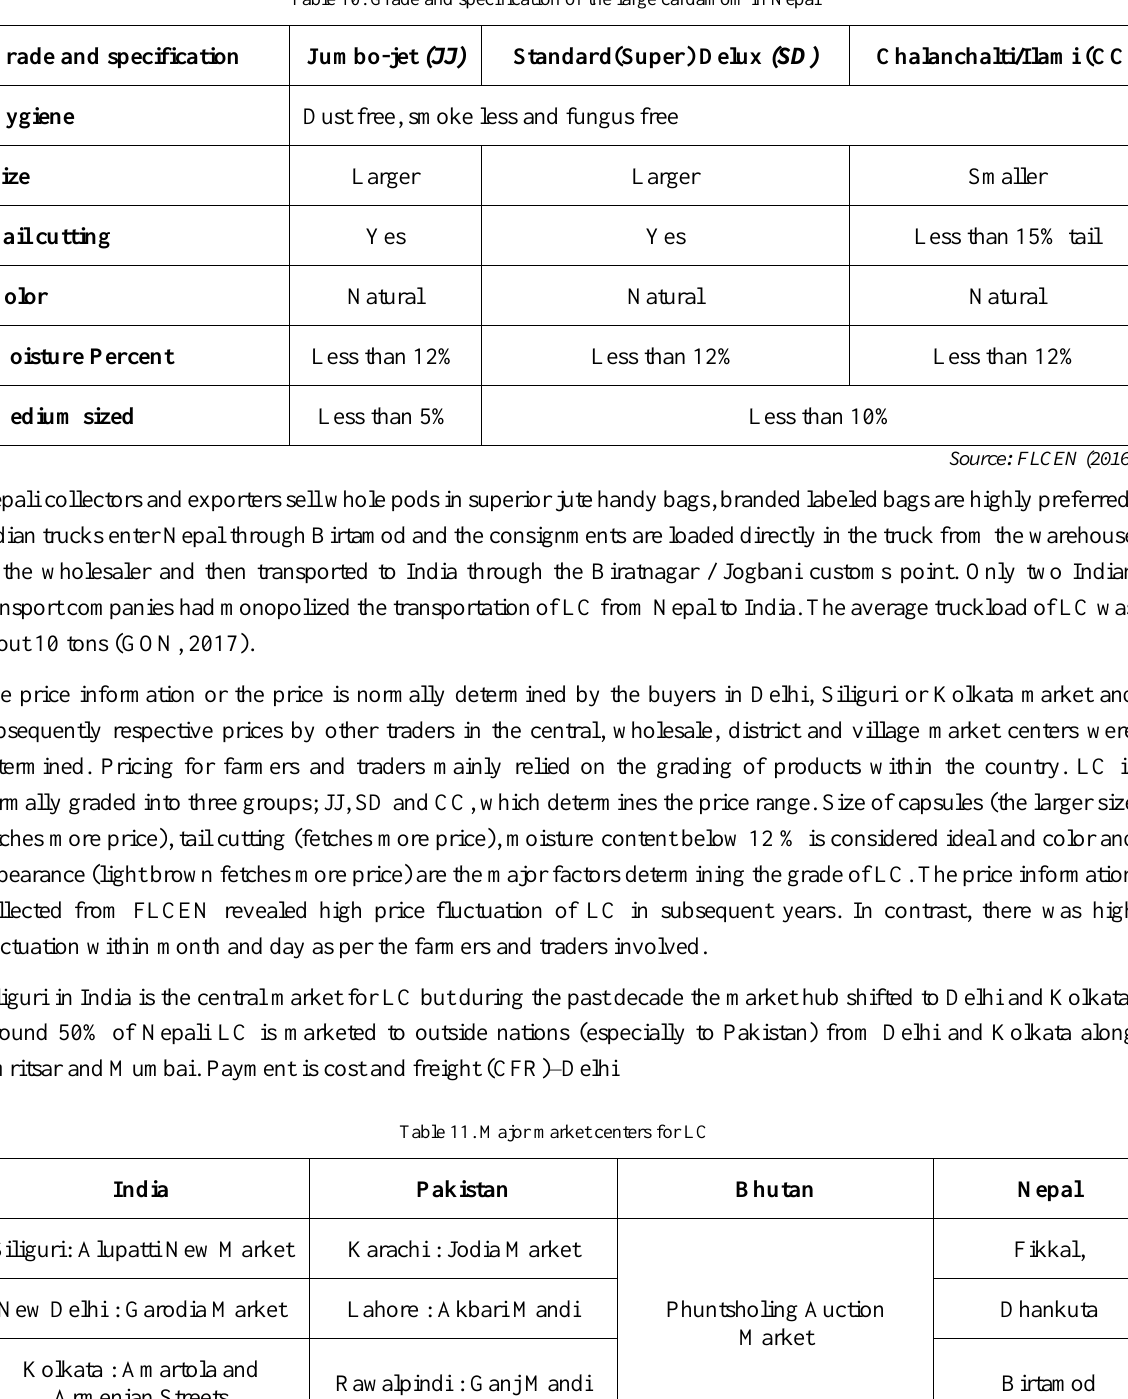
Table 10. Grade and specification of the large cardamom in Nepal